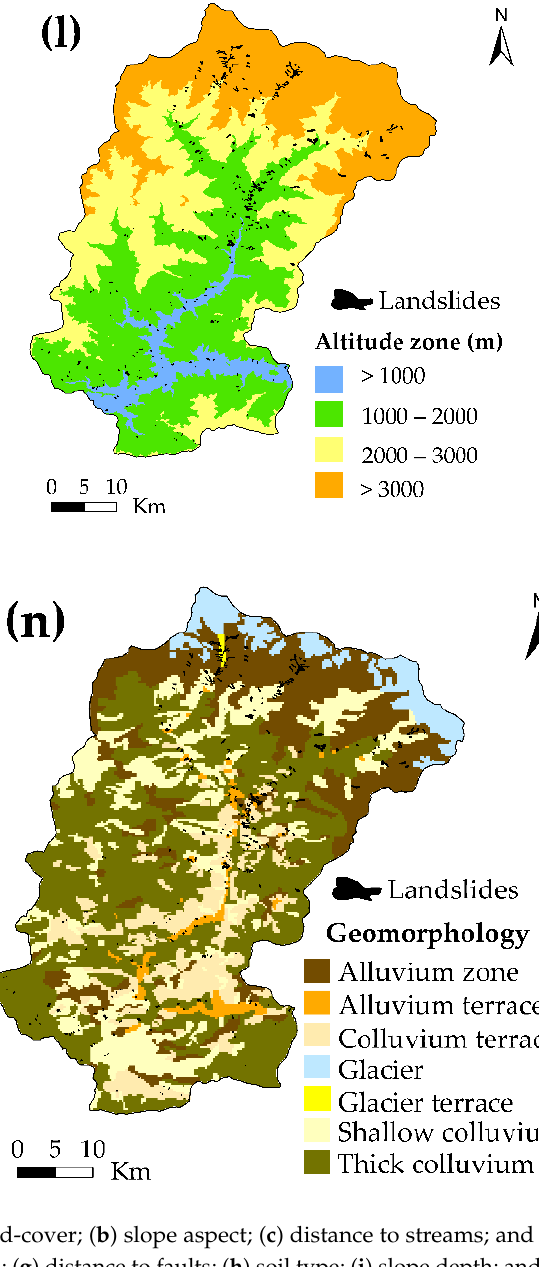
Figure 3. Landslide causative factors for the study area: ( a ) land-cover; ( b ) slope aspect; ( c ) distance to streams; and ( d ) distance to roads; ( e ) distance to thrust; ( f ) distance to lineaments; ( g ) distance to faults; ( h ) soil type; ( i ) slope depth; and ( j ) relative relief; ( k ) slope angle; ( l ) altitude zone based on rainfall; ( m ) lithology; and ( n ) geomorphology.